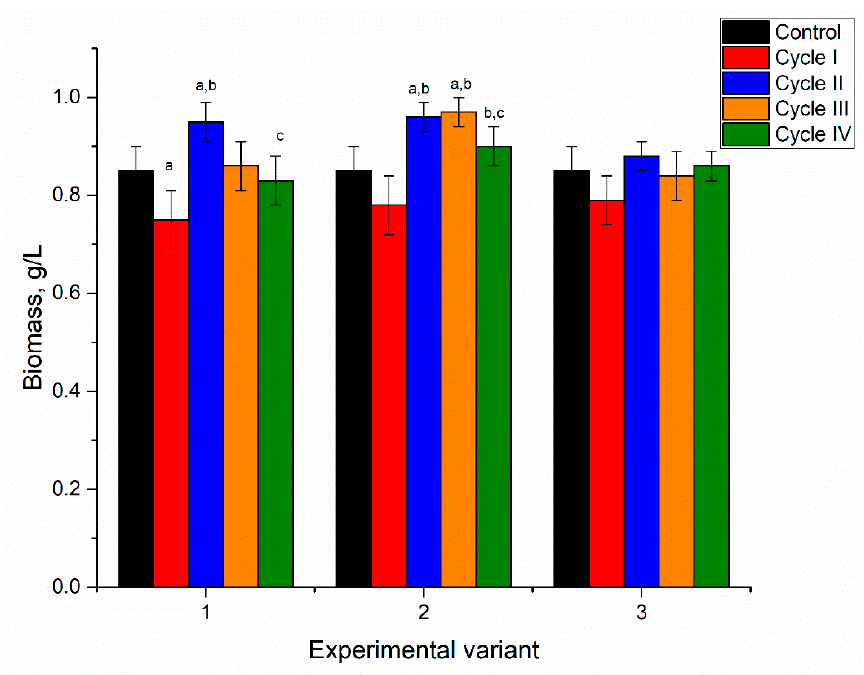
Figure 5. The amount of spirulina biomass during repeated cultivation in a medium containing metal ions at concentrations: nickel 2.5–10 mg/L, chromium and iron 1.25–5 mg/L. a: p < 0.001 for the difference between experimental and control samples; b: p < 0.001 for the difference with the first cycle; c: p < 0.001 for the difference with the second cycle.